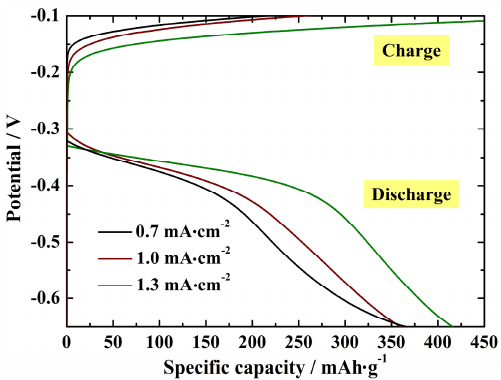
Figure 6. Charge/discharge curves at a specific current of 1 A ∙ g − 1 for the electrodeposited V 2 O 5 coatings at room temperature using 0.7, 1.0, 1.3 mA ∙ cm − 2 at a constant electrolyte concentration of 0.5 M.